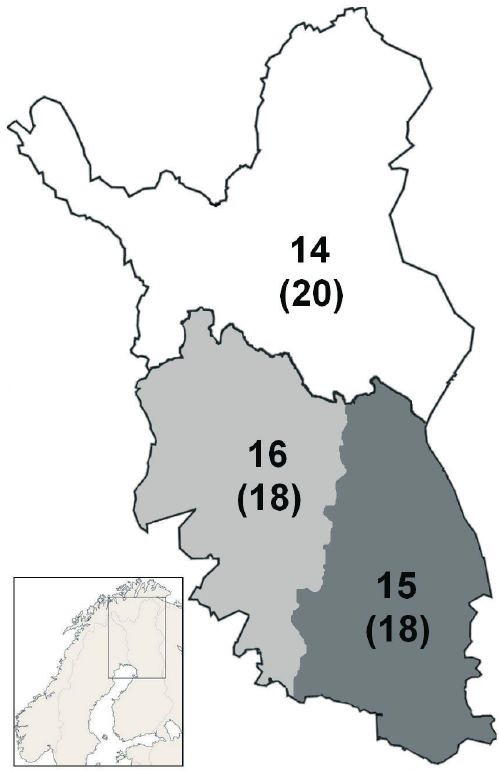
Fig.1. The number of interviewed cooperatives (vs. all cooperatives in brackets) in the three subregions (north, middle and south) of the reindeer herding area in Finland. The map configuration was given by the Reindeer Herders’ Association